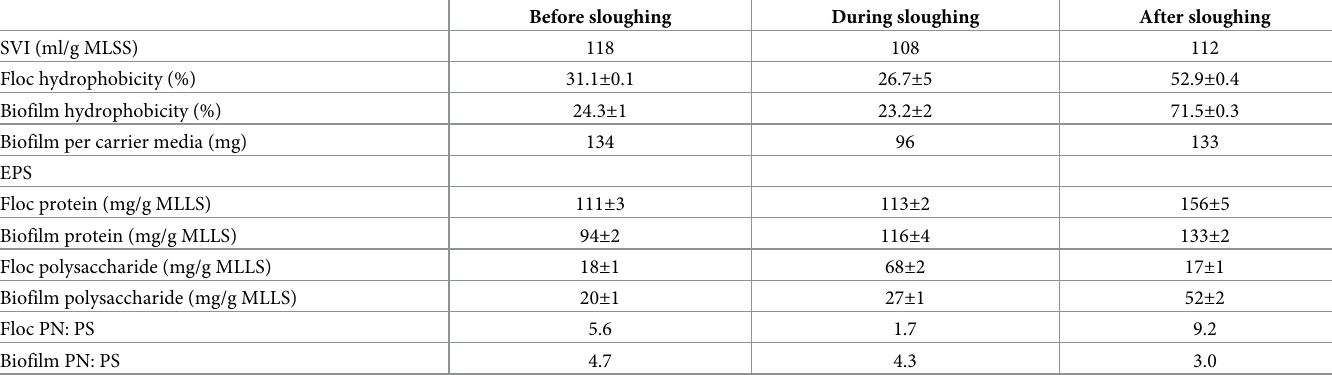
Table 2. Properties of FS IFAS biofilms and flocs associated with biofilm